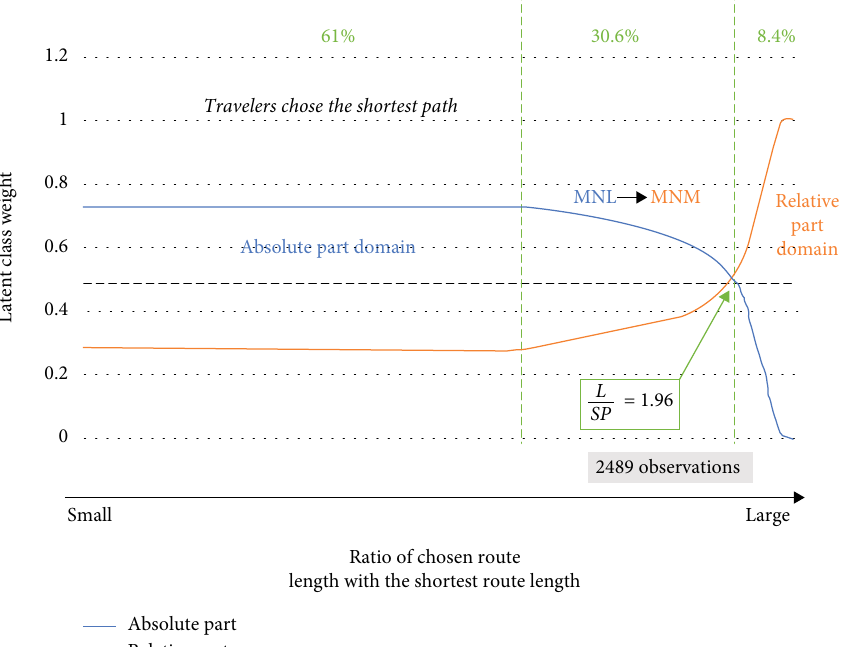
Figure 10: Relationship between the weight of latent class and ratio of chosen route length with the shortest route length.